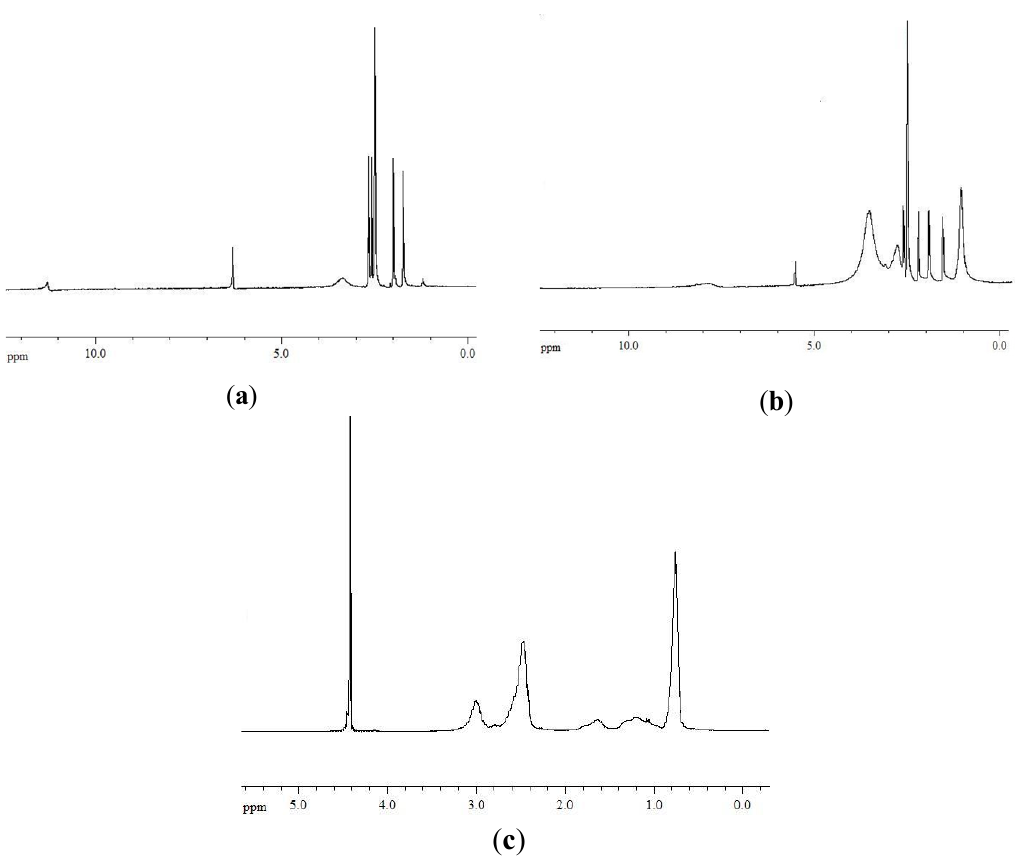
/UA 70/30 complex ( b ) and T=0